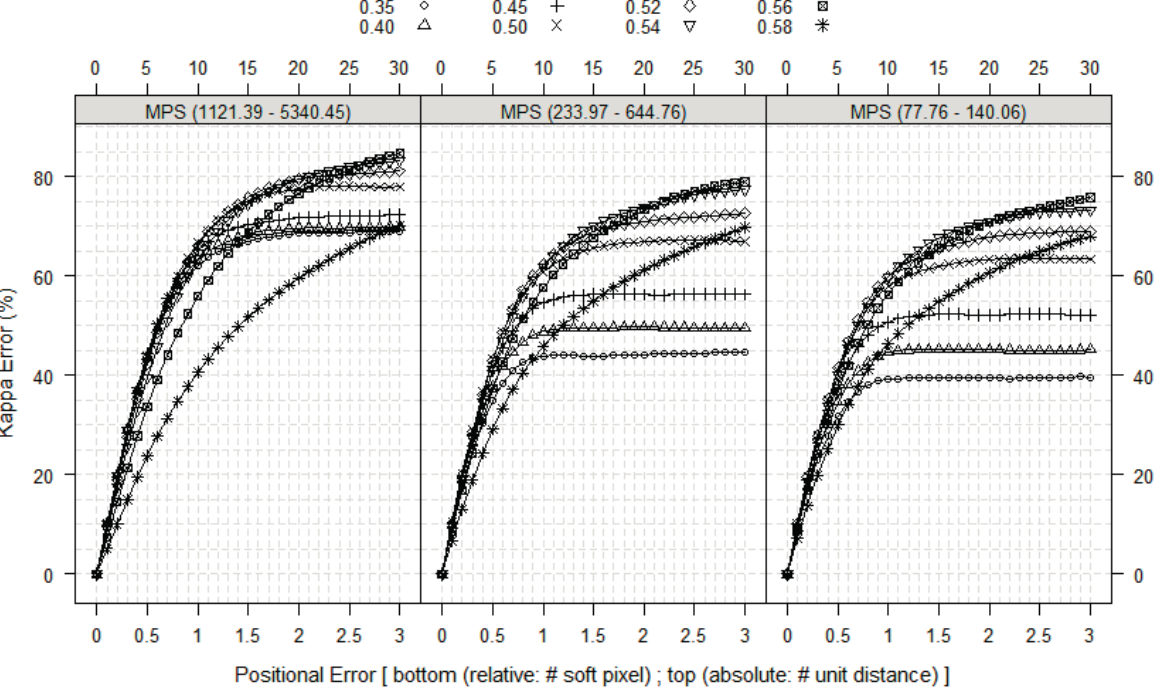
Figure 10. Impact of positional error on kappa-error at different landscape characteristics using a spatial resolution of 10 unit